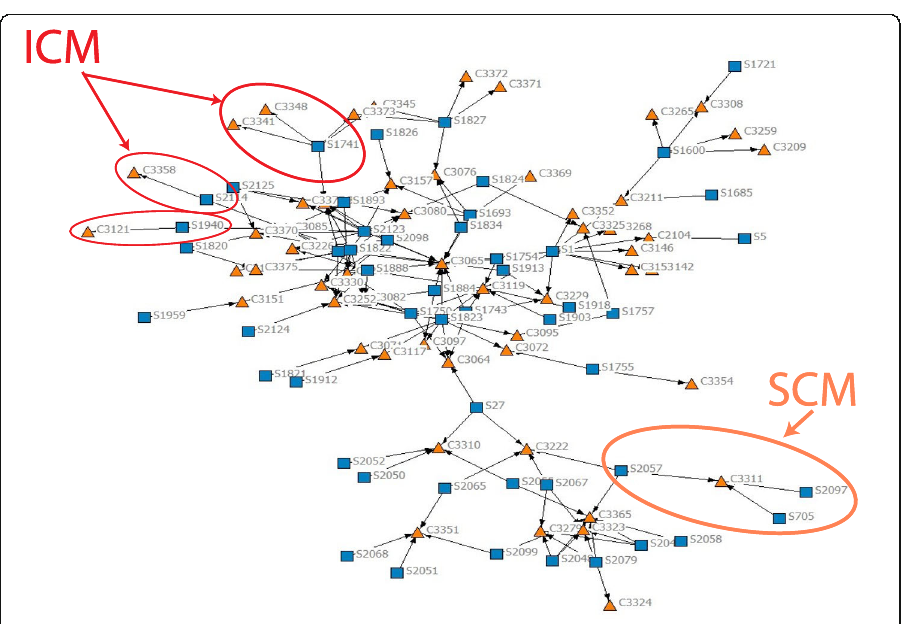
Fig. 6 Concept map modification and reading graph